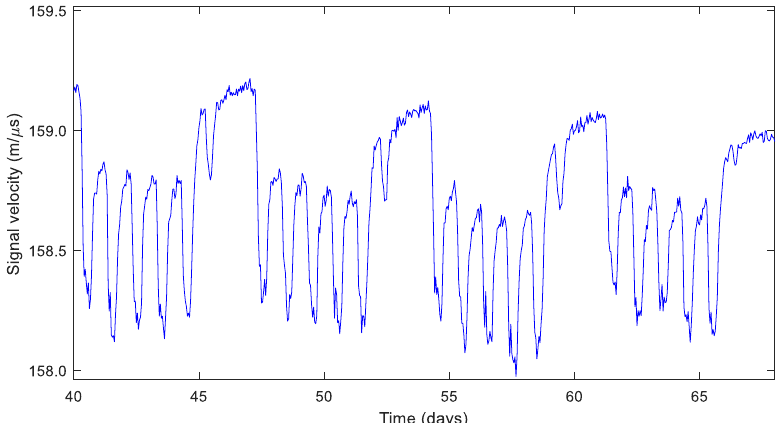
Figure 1. Measured variation in signal propagation velocity of a 1195 m mass-impregnated cable from load cycles during four weeks’ operation (based on data from [1]); days are counted from the beginning of the year 2014 and the full vertical scale corresponds to a temperature variation of 10 °C (according to the thermal model in [3]).